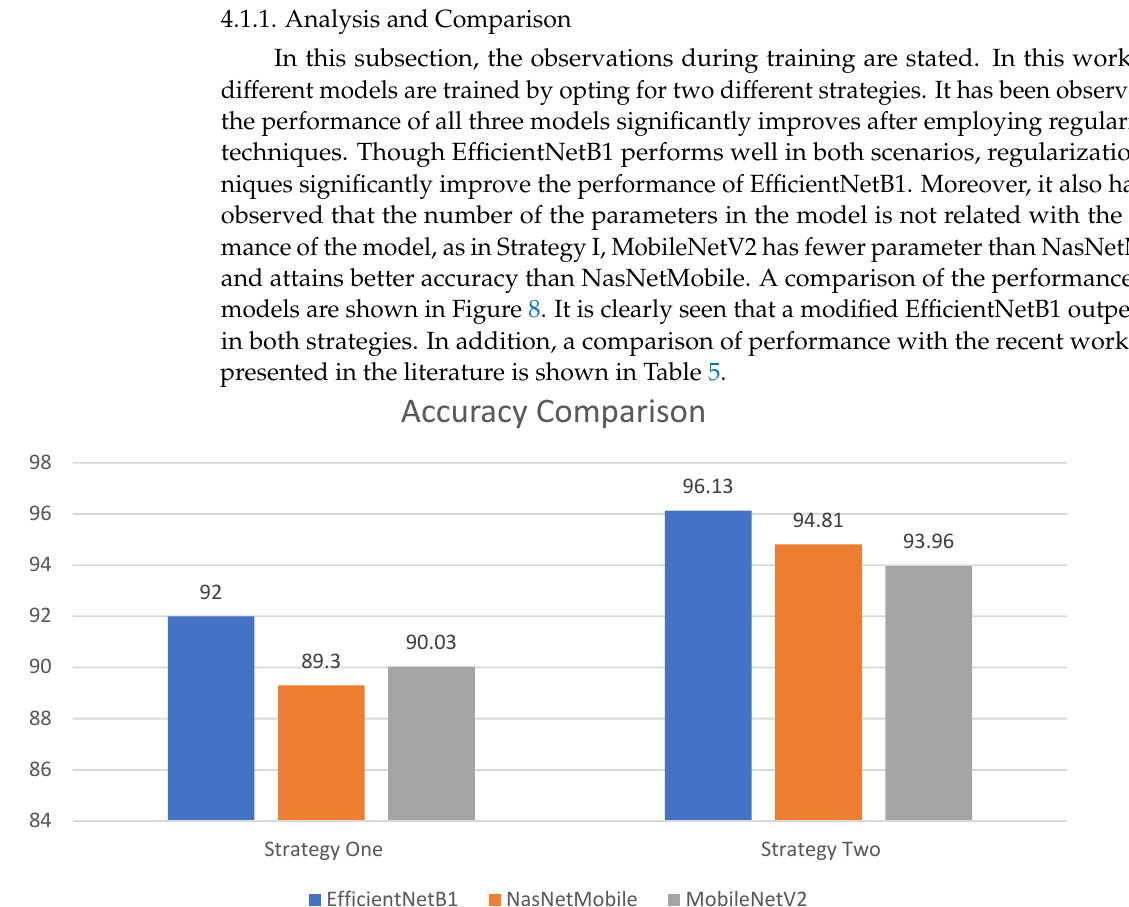
Figure 7. Training plots of the best performing model, EfficientNetB1: ( a ) accuracy plot; ( b ) loss plot.